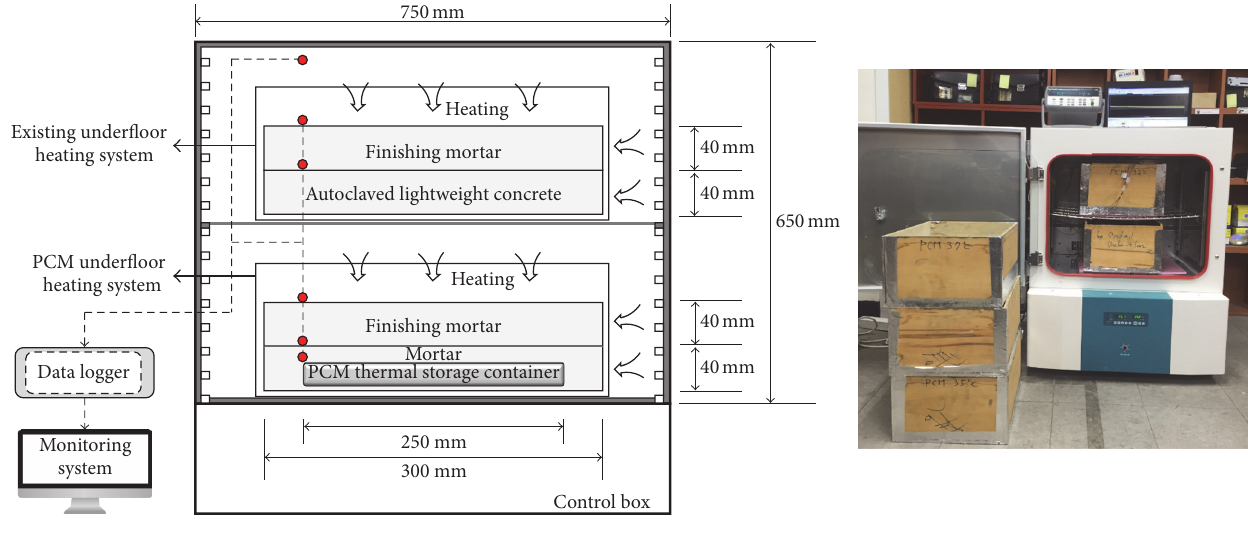
Figure 6: Construction of constant-temperature chamber and monitoring system.